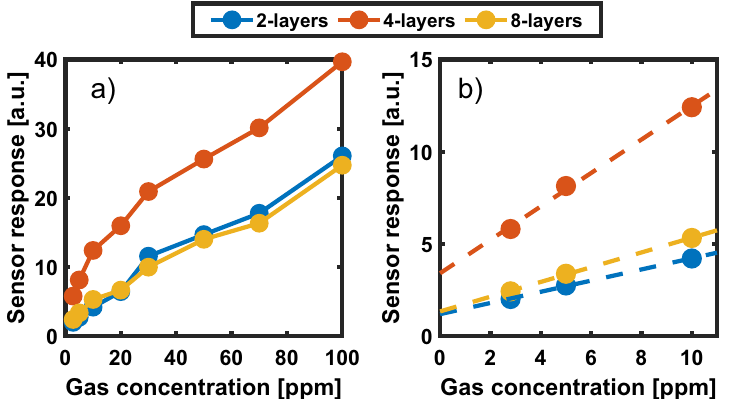
Figure 6. ( a ) Comparison between the responses of the 2-,4- and 8-layers devices at the various concentrations. ( b ) Linear fitting in the 2.8–10 ppm range.